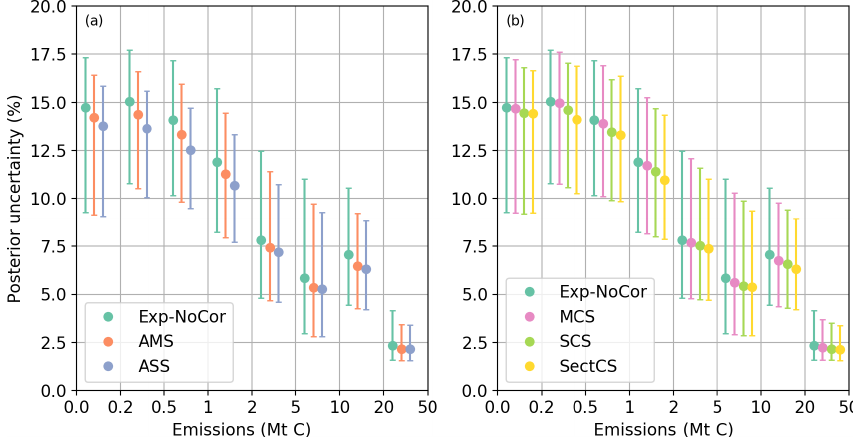
Figure 3. Distribution of the posterior uncertainty in the 3h mean emissions during the 08:30–11:30 time windows (for which the posterior uncertainty in 3h mean emissions are smaller than 20% in Exp-NoCor) obtained with different OSSEs. Dots and error bars are the median and interquartile range. The results are binned according to the clump annual emission with bin limits given on the x axis of the figure. Numbers at the figure top indicate the number of clumps and the percentage of clump emission within each